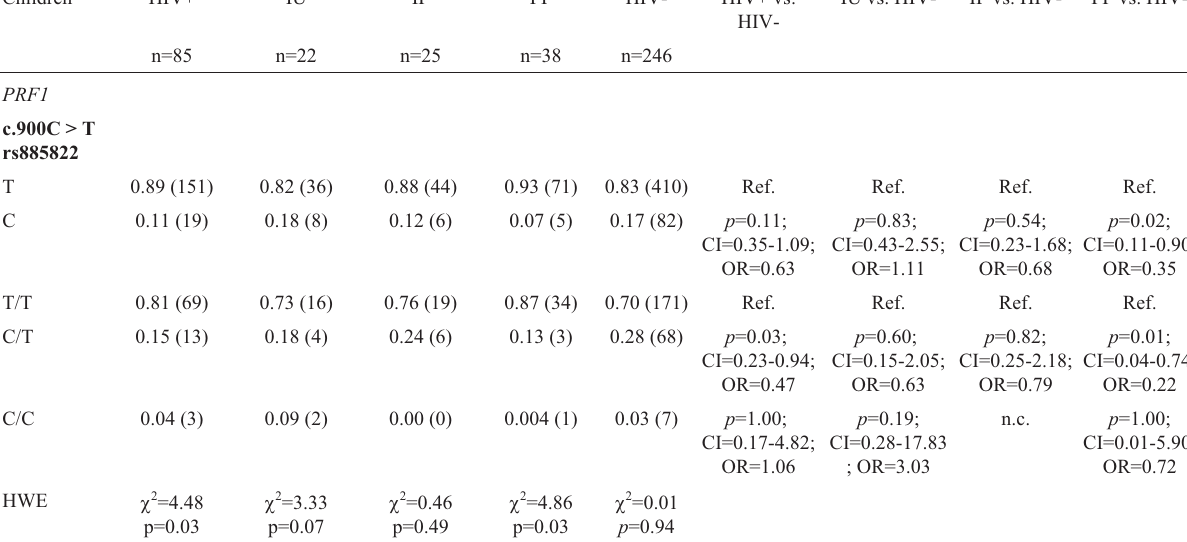
Table 1 - PRF1 polymorphism allele genotype frequencies (and counts) in HIV-1 exposed but not infected children (HIV-) and HIV-1 infected children (HIV+) stratifying for timing of HIV-1 mother to child transmission (MTCT) in intrauterine (IU) intrapartum (IP) and postpartum (PP) groups. Children HIV+